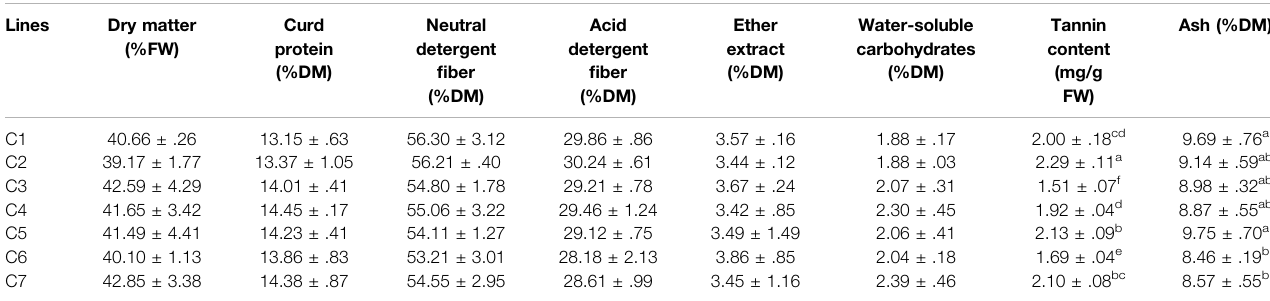
TABLE 2 | Comparison of nutrient content for seven Th. ponticum lines at the adult-plant stage.